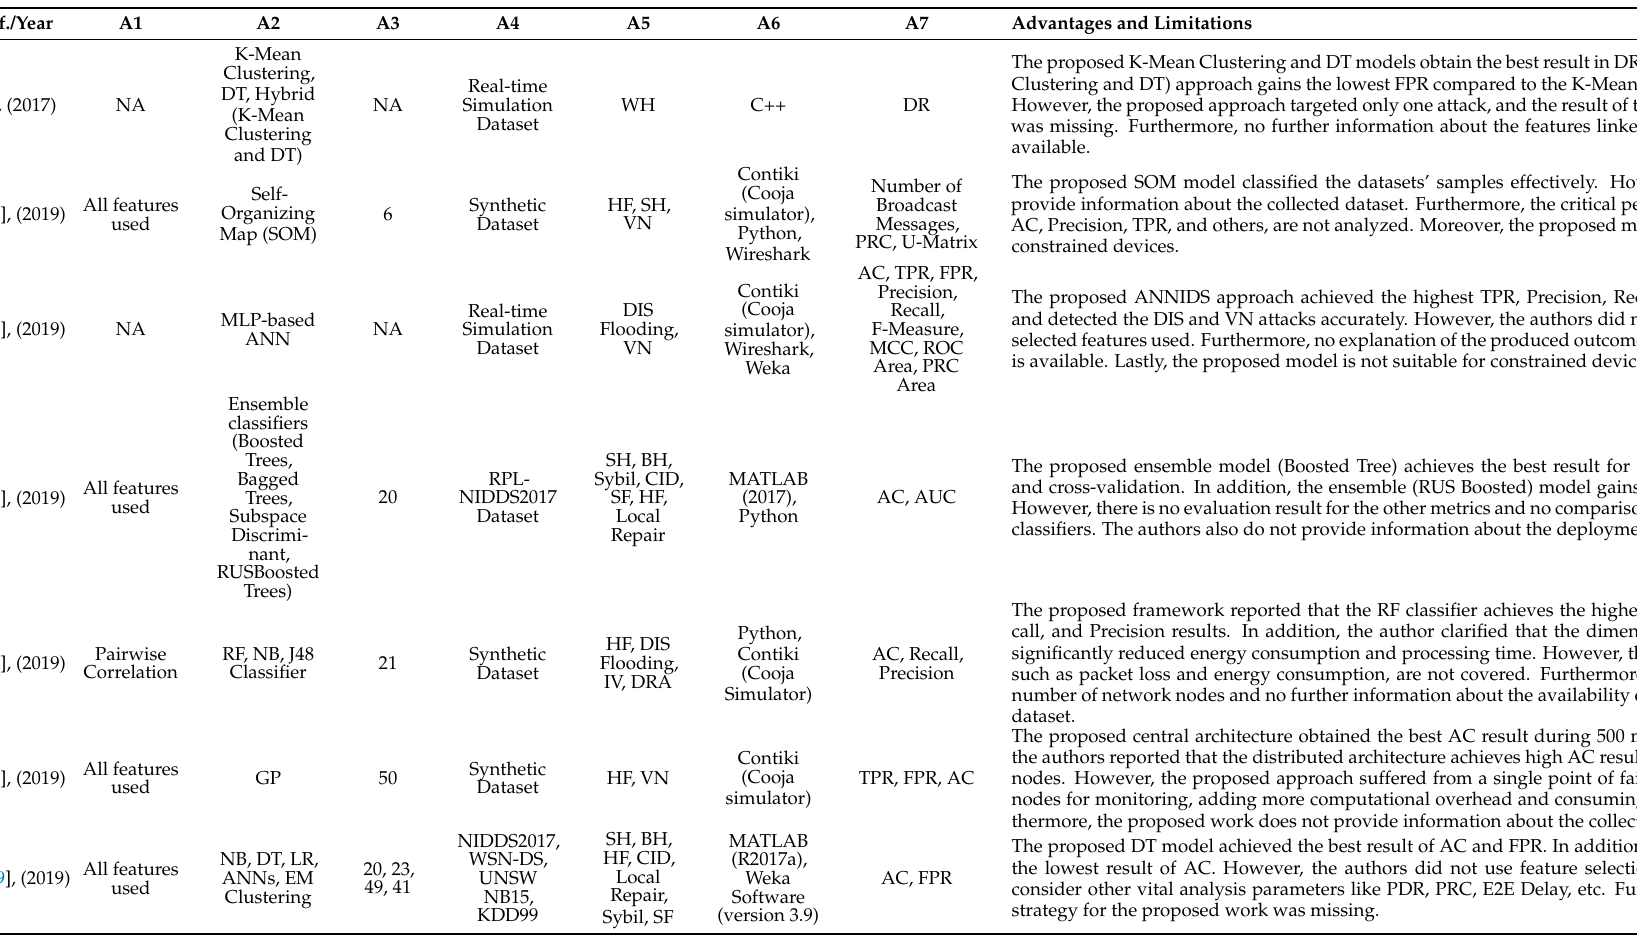
Table 2. Summary of machine learning-based